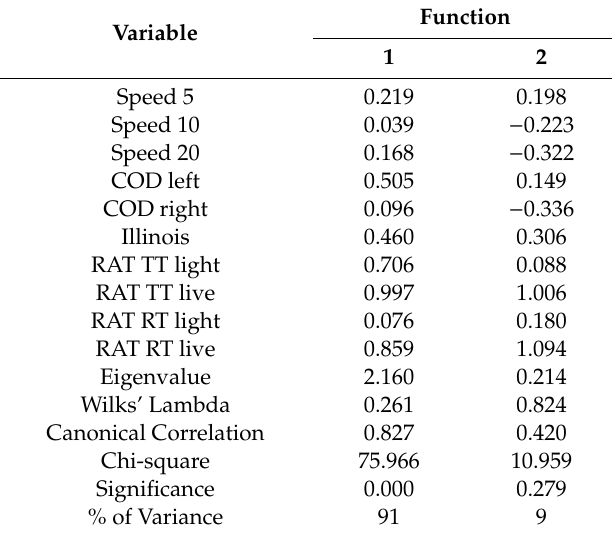
Table 3. Discriminant function structure coe ffi cients and tests of statistical significance. Function Variable 1 Speed 5 0.219